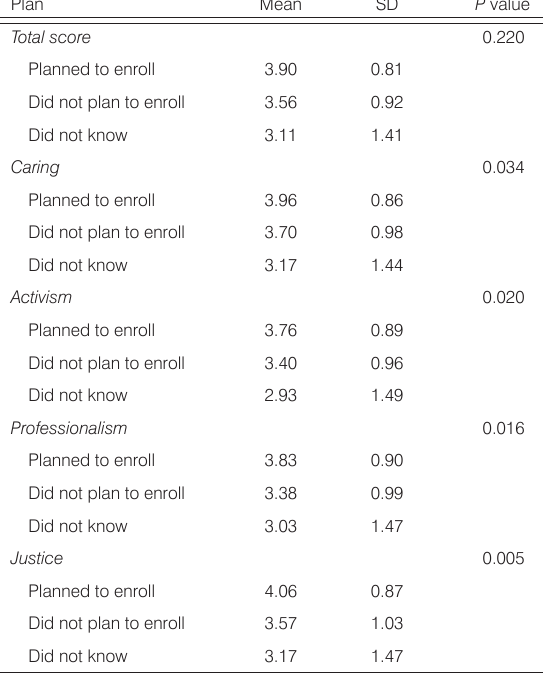
Table 5. Scores of NPVS-R and its domains in relation to students’ plan to study nursing at the time of